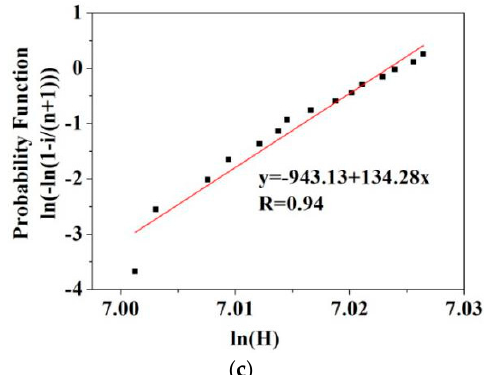
Figure 6. Linear fit of Weibull distribution of each load: ( a ) NiCr–5TiB 2 –5ZrB 2 ; ( b ) NiCr–10TiB 2 –10ZrB 2 ; and ( c ) NiCr–15TiB 2 –15ZrB 2 .